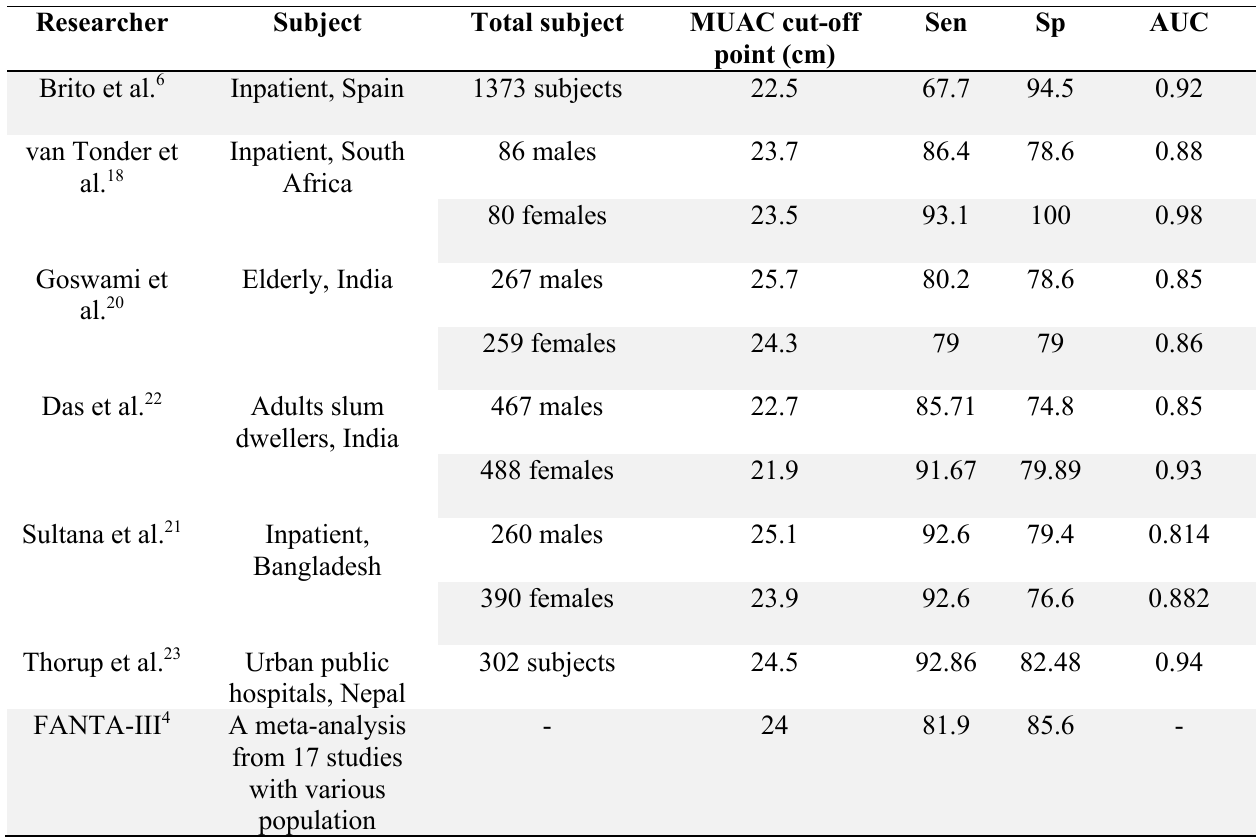
Table 2. The cut-off point of MUAC from various studies for detecting malnutrition